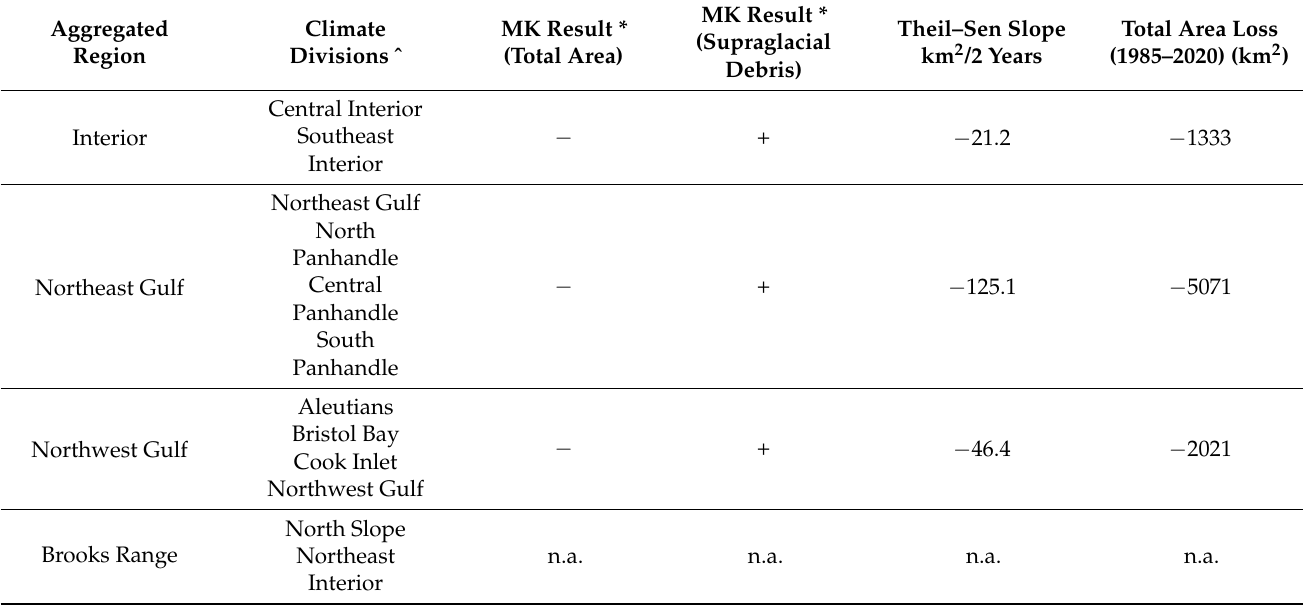
Table 2. Summary of climate division aggregations of Mann–Kandell (MK) trend test results and Theil–Sen slope (km 2 /2 years) for aggregated regions with statistically significant trends. Additional area values are included in Appendix